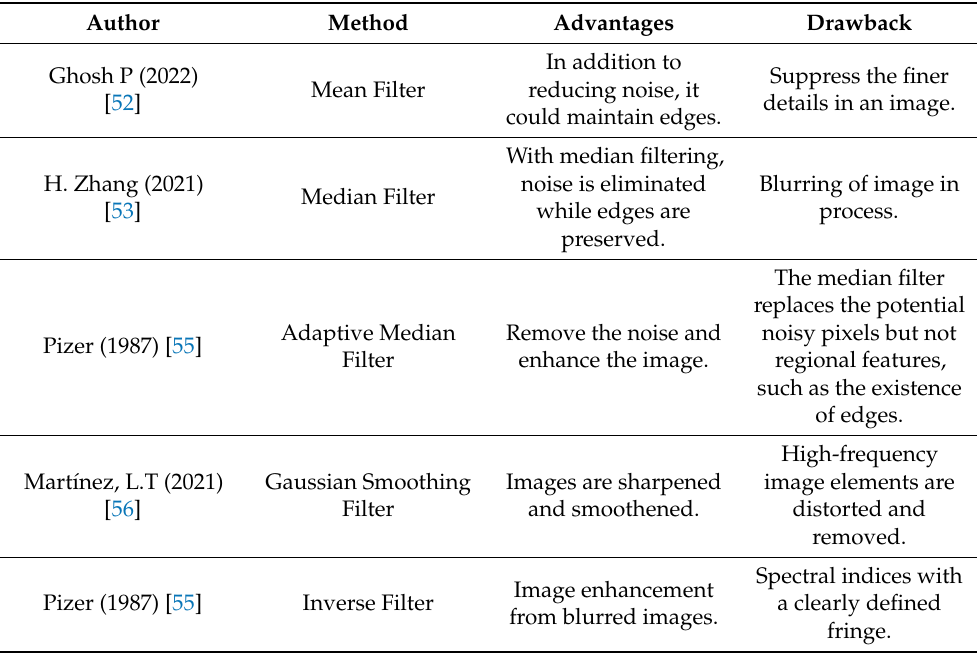
Table 3. Restoration of images by various filtering